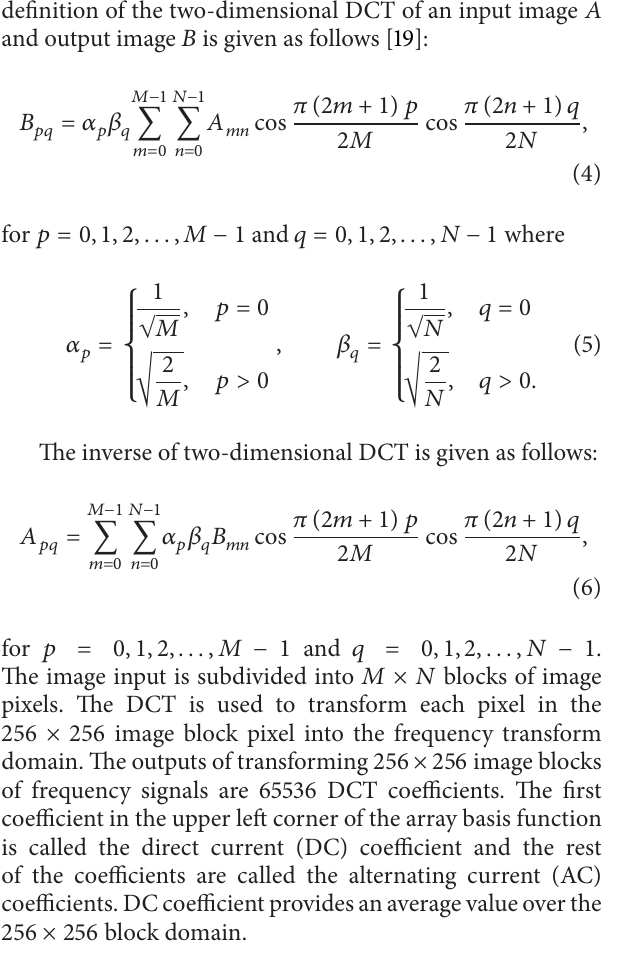
for 𝑥 = 0, 1, 2, . . . , 𝑁 − 1 and 𝑢 = 0, 1, 2, . . . , 𝑁 − 1 . The